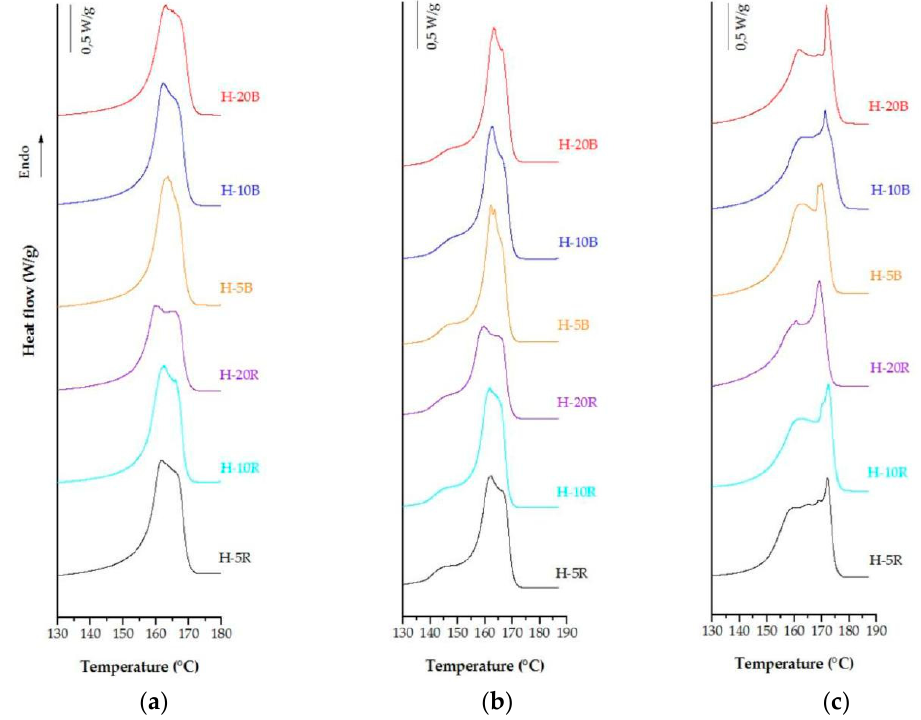
Figure 3. DSC thermograms of polymer blends prepared with the polypropylene (PP) random and block copolymers, ( a ) precursor films, ( b ) annealed precursor films at 140 °C, and ( c ) membranes.